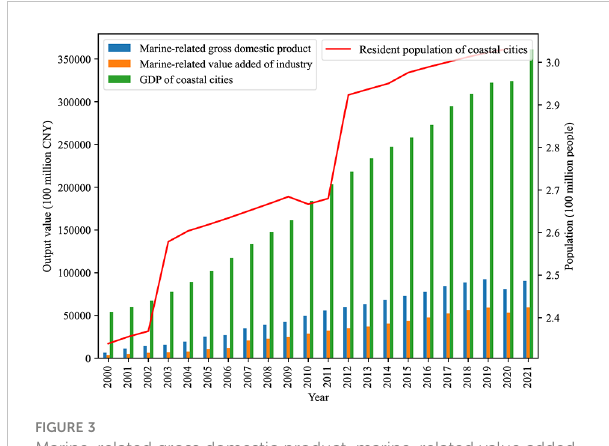
FIGURE 3 Marine-related gross domestic product, marine-related value added of industry, GDP of coastal cities, resident population of coastal cities.